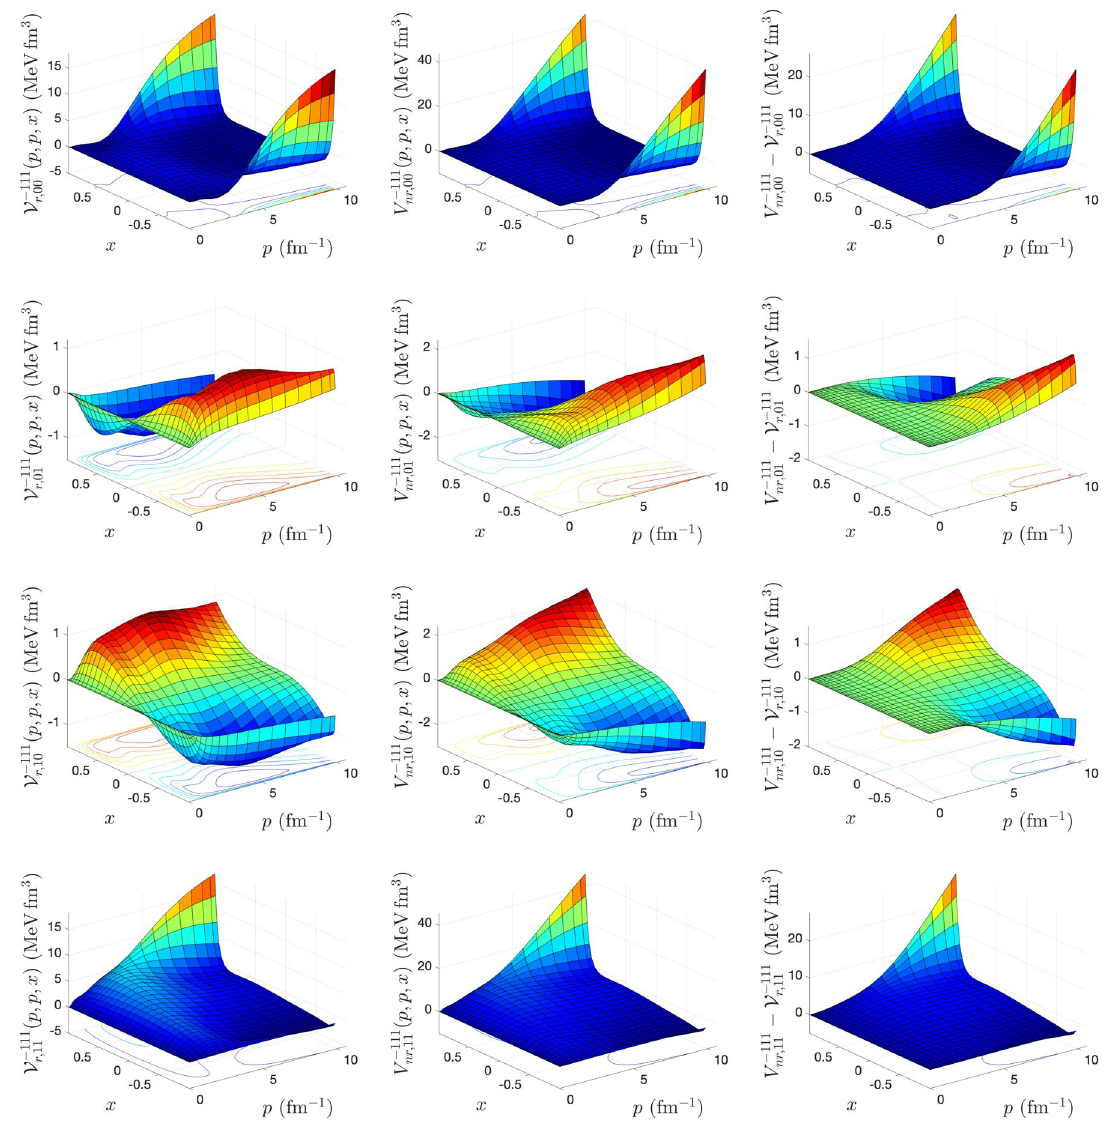
Figure 4. The same as Fig. 1, but for ( s